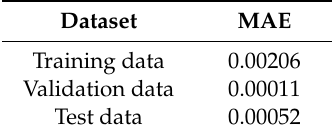
Figure 15. Error functions of the RNN-LSTM for Process 3. Table 5. Error functions for Process 3.